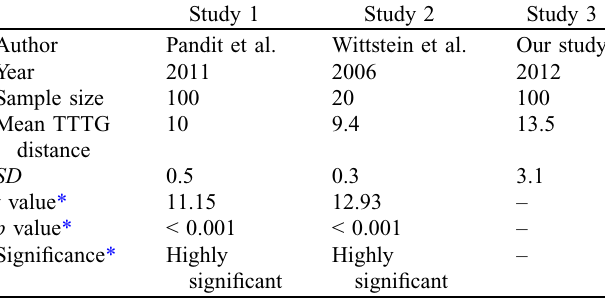
Table 2. Comparison of all MRI studies.